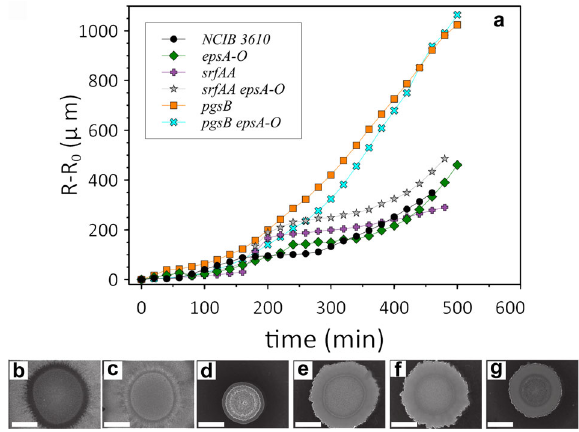
Fig. 4 Fluid extraction is driven by PGA production. a Measurements of the outer edge displacement at 38 ∘ C show that NCIB 3610 (black circles), epsA-O (green diamonds), the srfAA (purple plus), and srfAA epsA-O (grey star) strains possesses the characteristic ` fl uidization plateau'. The pgsB minus (orange square), and pgsB epsA-O minus strain (cyan cross) that cannot produce PGA did not exhibit this behaviour. Colony morphology after 48 hours incubation at 38 ∘ C of b NCIB 3610, c pgsB, d srfAA, e epsA-O , f pgsB epsA-O , and g srfAA epsA-O . Scale bar is 5